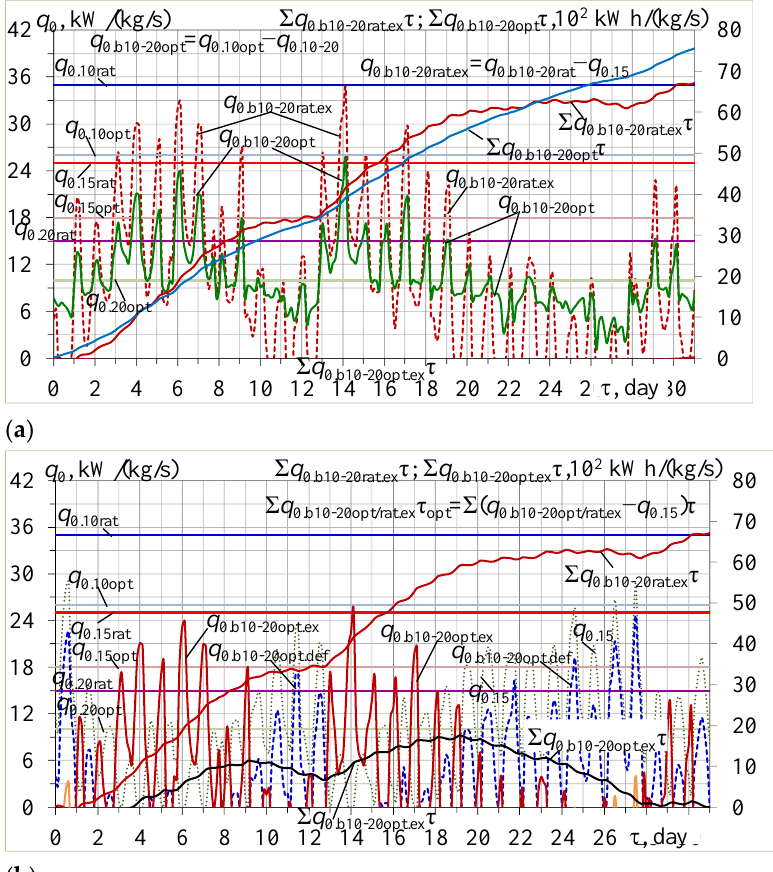
Figure 5. Current values of refrigeration capacities q 0.15 needed for preconditioning outdoor air to 15 °C; booster optimal refrigeration capacity q 0.b10-20opt and corresponding summarized monthly refrigeration energy values Σ q 0.b10-20opt τ , current exceedances of booster rational refrigeration capacities q 0.b10-20rat.ex and corresponding summarized data Σ q 0.b10-20rat.ex τ ( a ), current booster optimal refrigeration capacity exceedance q 0.b10-20opt.ex and its deficit q 0.b10-20opt.def , summarized booster refrigeration energy exceedance for optimal ∑ q 0.b10-20opt.ex and rational data ∑ q 0.b10-20rat.ex ( b ).